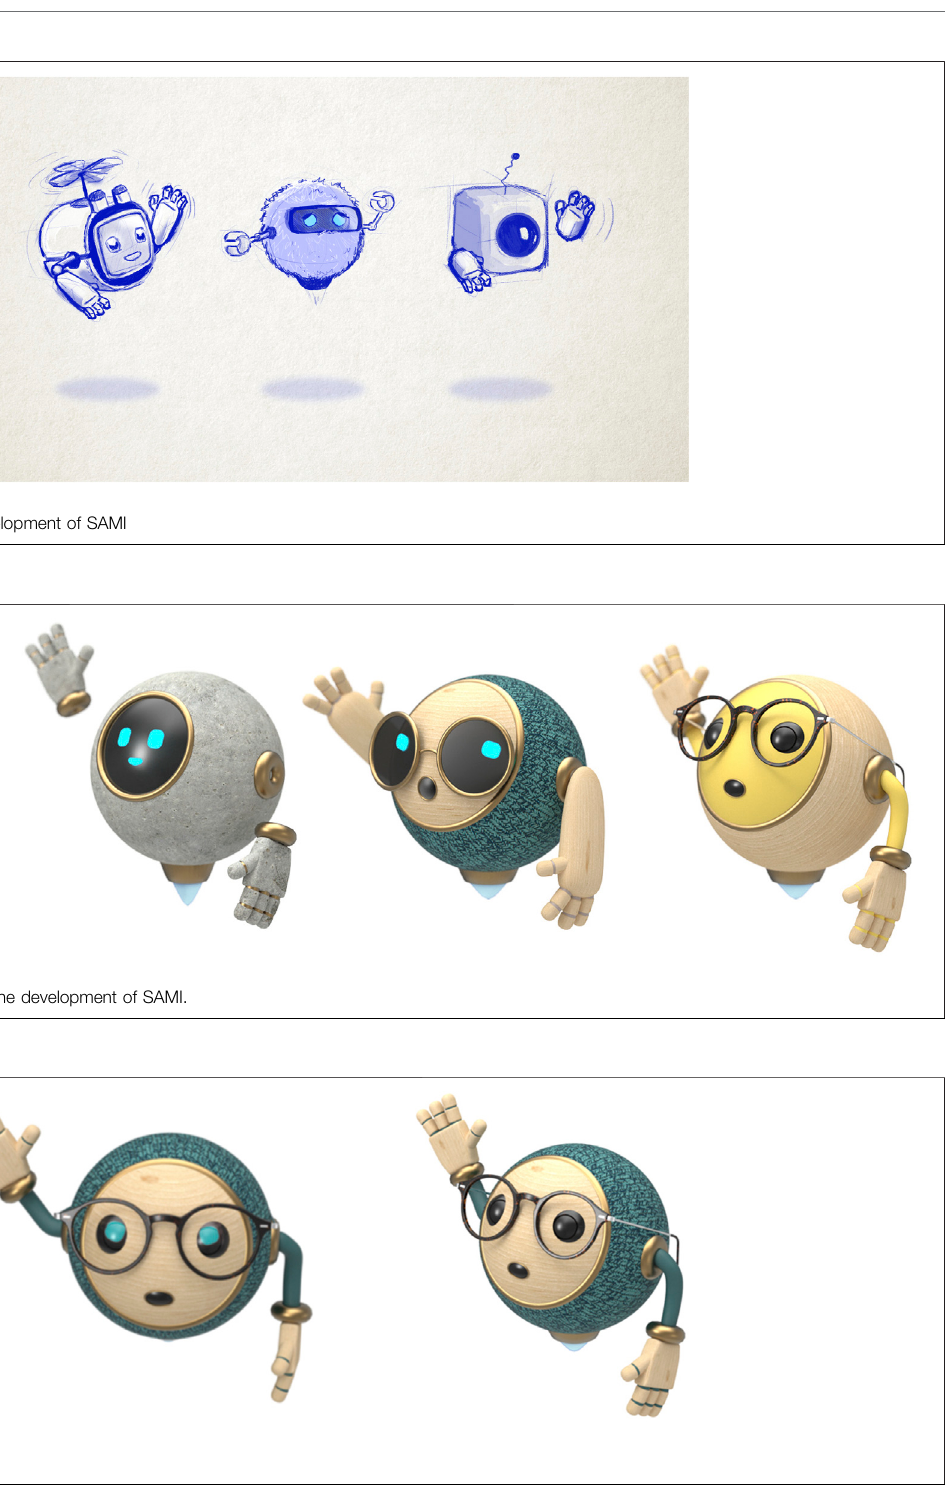
and Figure 3 the fi nal sketch for SAMI used in the experience.